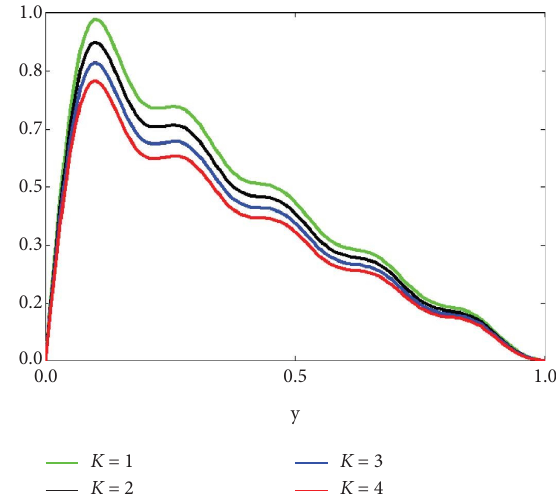
Figure 4: Te impact of diferent values of K on ψ ( y, t )